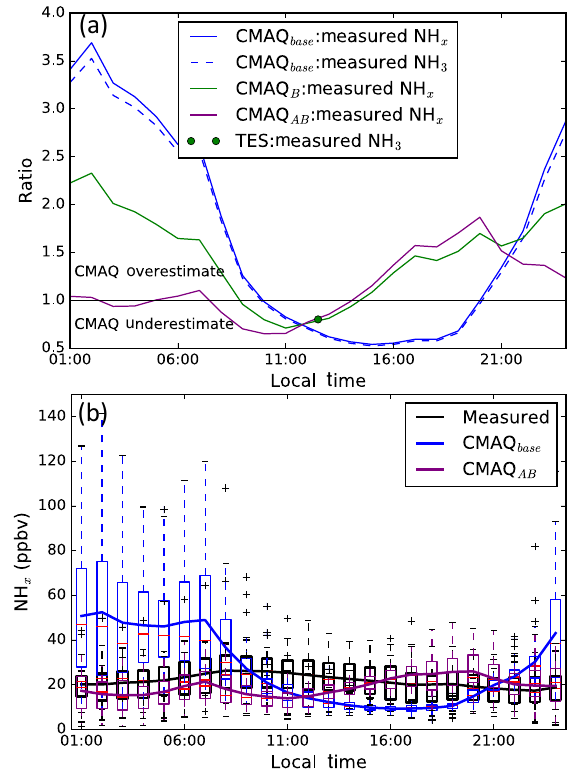
Figure 2. (a) The average hourly ratio of modeled to measured NH 3 (dashed line) and NH x (solid line) mixing ratios at the Bak- ersfield ground site for the CMAQ base (blue), CMAQ B (green) and CMAQ AB (purple) cases, and the average modeled RVMR to TES RVMR ratio (green dot) in local time. (b) Box plot of average hourly NH x mixing ratios at the Bakersfield ground site for the measured (black), CMAQ base (blue) and CMAQ AB (purple) cases, averaged over all measurement days during CalNex where the box plots show the inter-quartile range and median line (red) within the box and outliers (whiskers), with the solid lines showing the mean for that